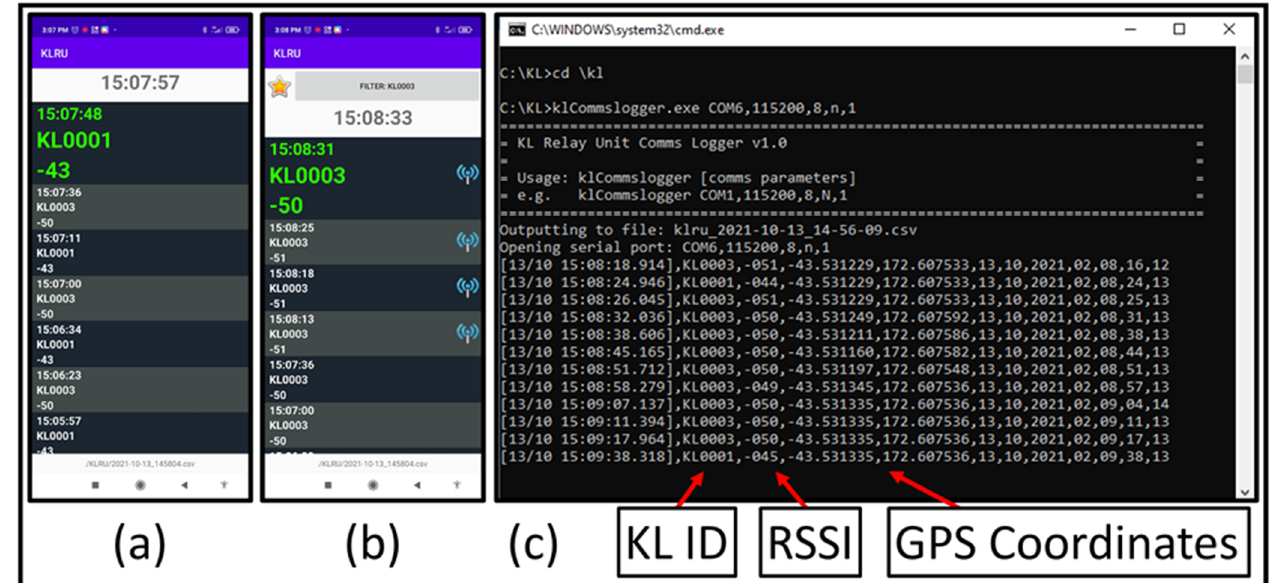
Figure 5. ( a ) KLRU android application for viewing LoRa messages with Kinematic Logger ID